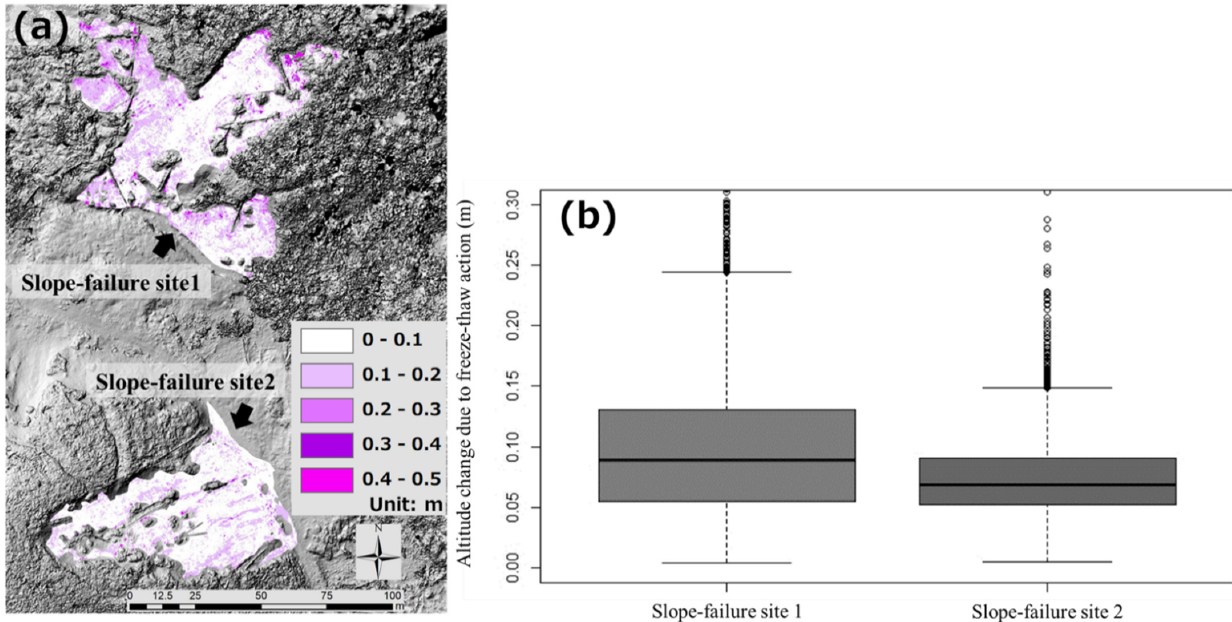
Figure 6. ( a ) Map of the freeze-thaw amount (Figure 5a,b). ( b ) Comparison of the freeze-thaw amount at each site.